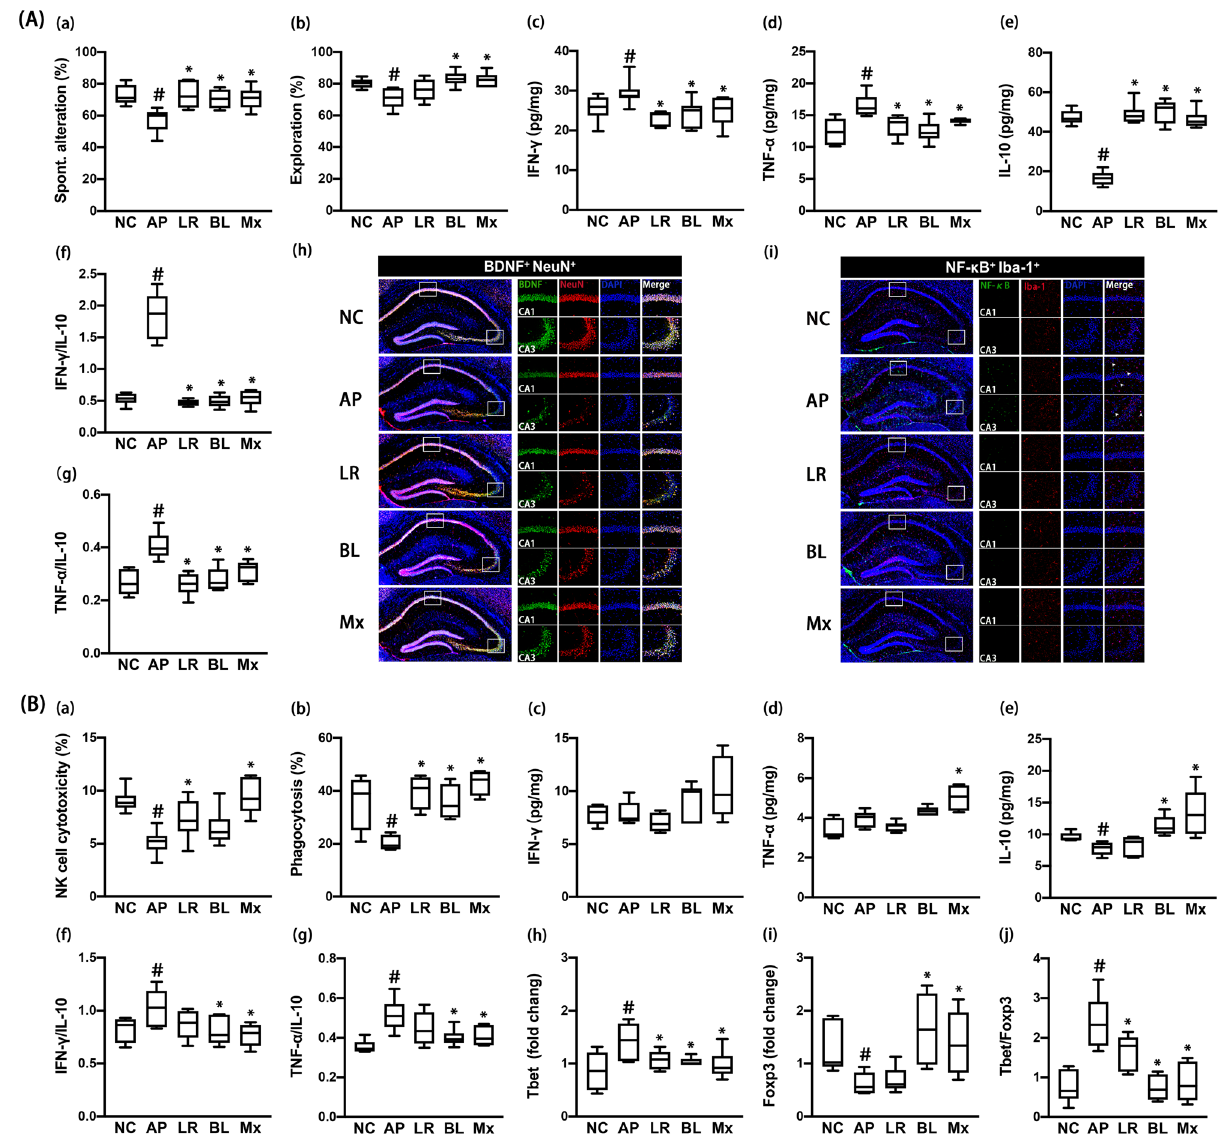
Figure 3. Effects of NK210 and NK219 on ampicillin-induced immune imbalance and cognitive impairment in mice. ( A ) Effects on cognitive impairment in the Y-maze (a) and NOR task (b). Effects on neuroinflammation: IFN-γ (c), TNF-α (d), IL-10 expression (e), IFN-γ to IL-10 expression ratio (f), TNF-α to IL-10 expression ratio (g), and BDNF + /NeuN + (h) and NF-κB + /Iba1 + cell populations (i) in the hippocampus. ( B ) Effects on the immune imbalance: splenic NK cell cytotoxicity activities (a), peritoneal macrophage phagocytosis (b), IFN-γ (c), TNF-α (d), and IL-10 expression (e), IFN-γ to IL-10 expression ratio (f), TNF-α to IL-10 expression ratio (g), Tbet (h) and Foxp3 expression (i), and Tbet to Foxp3 expression ratio (j) in the spleen. Test agents (AP, ampicillin alone; LR, 1 × 10 9 CFU/mouse/day of NK210; BL, 1 × 10 9 CFU/mouse/day of NK219; Mx, 1 × 10 9 CFU/mouse/day of LR and BL [4:1] mix) were orally gavaged daily for 5 days after oral gavage of ampicillin. Normal control mice (NC) were treated with vehicle (saline) instead of test agents. Data values indicate mean ± SD (n = 8). # p < 0.05 versus NC group. * p < 0.05 versus AP group treated with ampicillin (PCoA) (Fig. 4B, Supplementary Tables S1–S4). Ampicillin treatment also altered the gut microbiota composi- tion: they suppressed the Bacteroidetes and Firmicutes populations at the phylum level, while Proteobacteria and Verrucomicrobita populations were increased. Oral administration of NK210, NK219, or Mx partially restored the gut microbiota composition to that of normal control mice. They shifted the α- and β-diversities of ampicillin-induced gut microbiota to those of normal control mice. Of these, Mx most potently shifted them. They also increased Firmicutes and Bacteroidetes populations including Lachnosipracease, Muribaculaceae, and Prevotellaceae and decreased Proteobacteria and Verrucomicrobia populations including Bacteroidaseceae, Erysipelotrichaceae, Sutterellaceae, and Enterobacterales_f in the gut microbiota of mice with LPS-induced sys- temic inflammation. The correlation between gut microbiota populations and IFN-γ to IL-10 or Tbet to Foxp3 expression ratio was also analyzed in the gut and spleen (Fig. 4C,D). At the phylum level, Verrucomicrobia